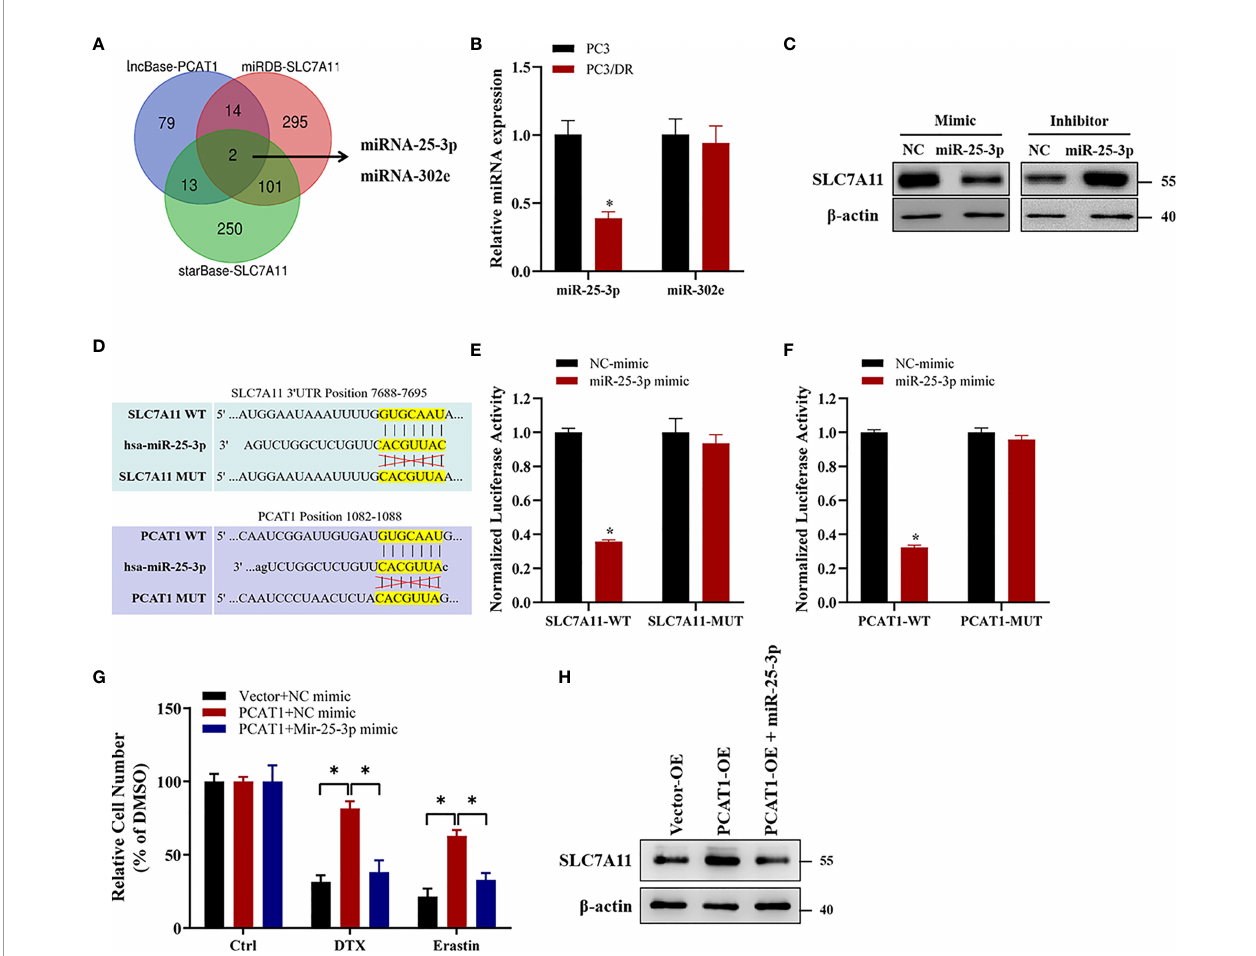
FIGURE 7 | PCAT1 facilitates SLC7A11 expression by competing for miR-25-3p. (A) Venn diagram showing the possible target microRNAs of both PCAT1 and SLC7A11 by three online databases (i.e., lncBase, miRDB and StarBase). (B) qRT-PCR assay was used to detect the expression of miR-25-3p and miR-302e in PC3/ DR and PC3 cells. (C) The protein levels of SLC7A11 in PC3/DR cells after transfected with miR-25-3p mimic and in PC3 cells after transfected with miR-25-3p inhibitor. (D) Schematic of SLC7A11 and PCAT1 wild-type (WT) and mutant (MUT) luciferase reporter vectors. (E) Relative luciferase activities were evaluated in PC3/DR cells co- transfected with SLC7A11 WT and MUT and miR-25-3p mimics and negative control. (F) Relative luciferase activities were analyzed in PC3/DR cells co-transfected with PCAT1 WT and MUT and miR-25-3p mimics and negative control. (G) The cell viability was assessed by CCK-8 assay in PCAT1-overexpressed PC3 cells after transfected with miR-25-3p mimic and negative control. (H) The protein level of SLC7A11 was detected by Western blot in PCAT1-overexpressed PC3 cells after transfected with miR-25-3p mimic and negative control. The data are presented as the means ± S.D. of at least three independent experiments. * P